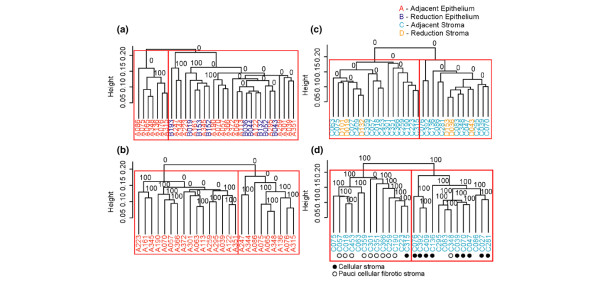
Hierarchical clustering with bootstrapping of adjacent and reduction breast tissues from gene expression data. (a) Hierarchical clustering with bootstrapping of adjacent and reduction epithelium. (b) Histologically normal adjacent and reduction stroma. (c) Histologically normal adjacent epithelium. (d) Histologically normal adjacent stroma. We used 10,000 bootstrap iterations to obtain significance scores for the observed clusters. Nodes are labeled with the percentage of times that the cluster is observed by bootstrapping. Only adjacent stroma showed statistically significant clusters at the top level. Red boxes indicate the top-level clusters that were tested for association with clinical characteristics of the samples.